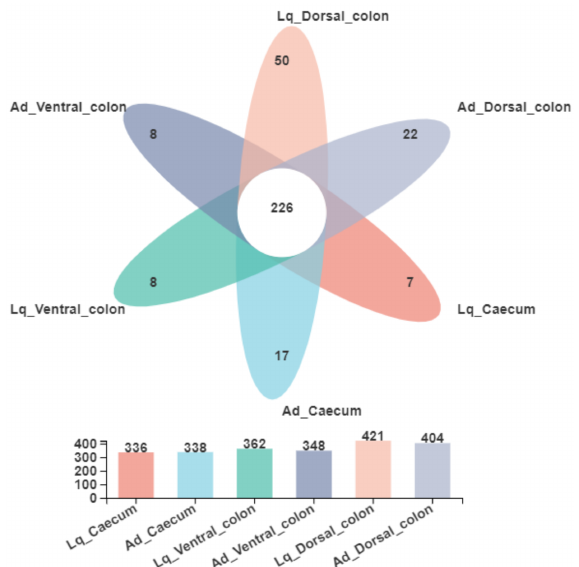
Figure 1. Venn diagram showed the distribution of the bacterial community OTUs at the genus level in the liquid phase (Lq) and adherent fraction (Ad) within the donkey caeco-colic